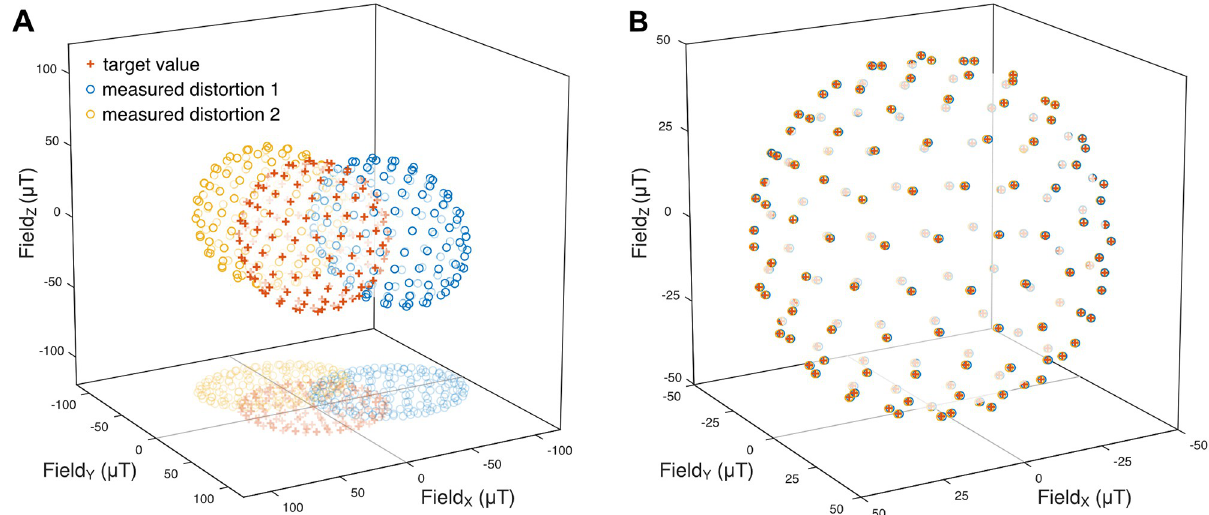
Fig 5. Compensation of strong distortions. A: A ferromagnetic steel bar was placed inside a previously calibrated setup in two orientations and a magnetic sphere stimulus with a target radius of 50 μ T was applied (red crosses). The resulting sphere was offset and deformed for both positions of the metal bar (blue and yellow circles). B: After calibration, offset and deformation of the sphere were largely reduced, yielding average errors of 0.63% (distortion 1, blue circles) and 0.51% (distortion 2, yellow circles).